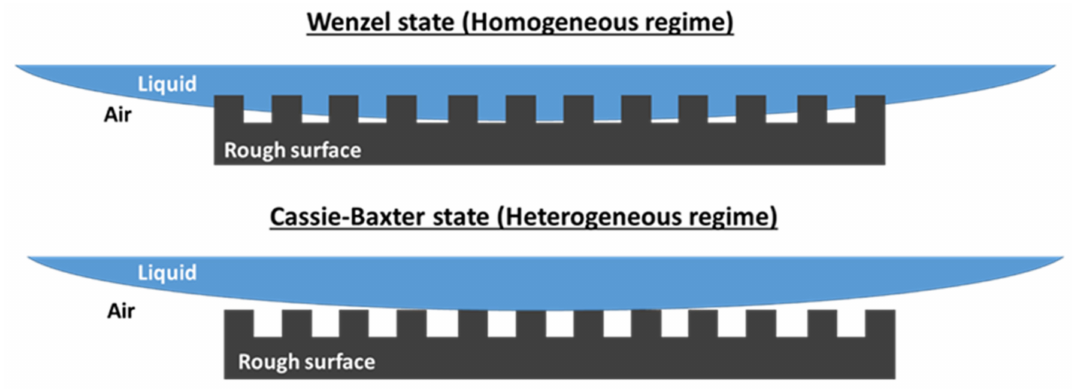
Figure 14. Cassie–Baxter and Wenzel states (heterogeneous and homogeneous